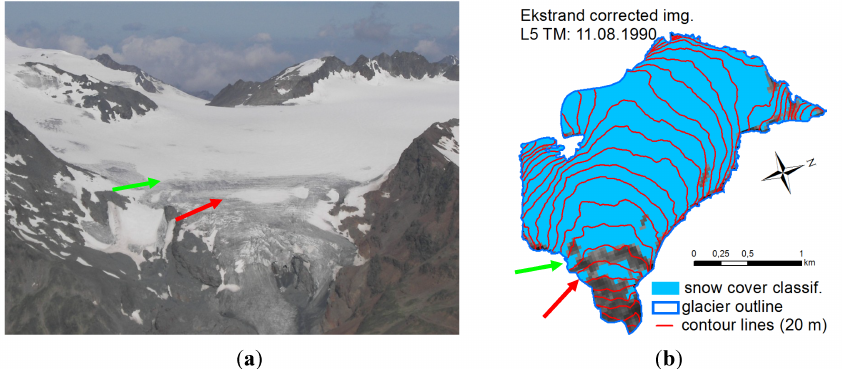
Figure 5. ( a ) Patchy distribution of SC on Kesselwandferner (photo by Christian Engl, 1 July 2007). ( b ) Classified SC distribution for similar snow conditions (11 August 1990). The usage of only one elevation bin (red arrow) for snow line altitude (SLA) determination could be erroneous, as the SC in one elevation bin is greater than 50%. The green arrow indicates the correct bin to derive the SLA. Figure reproduced from